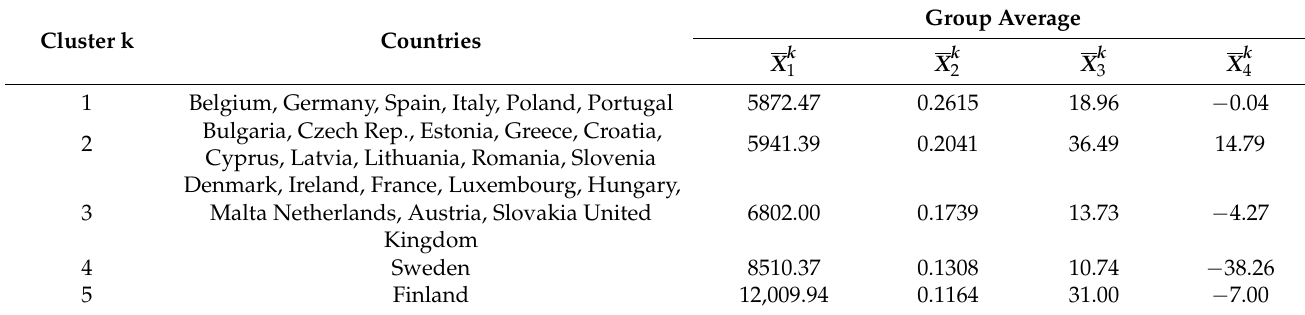
Table 3. Results of the EU countries clustering—the average values of the variables in the clusters. Cluster